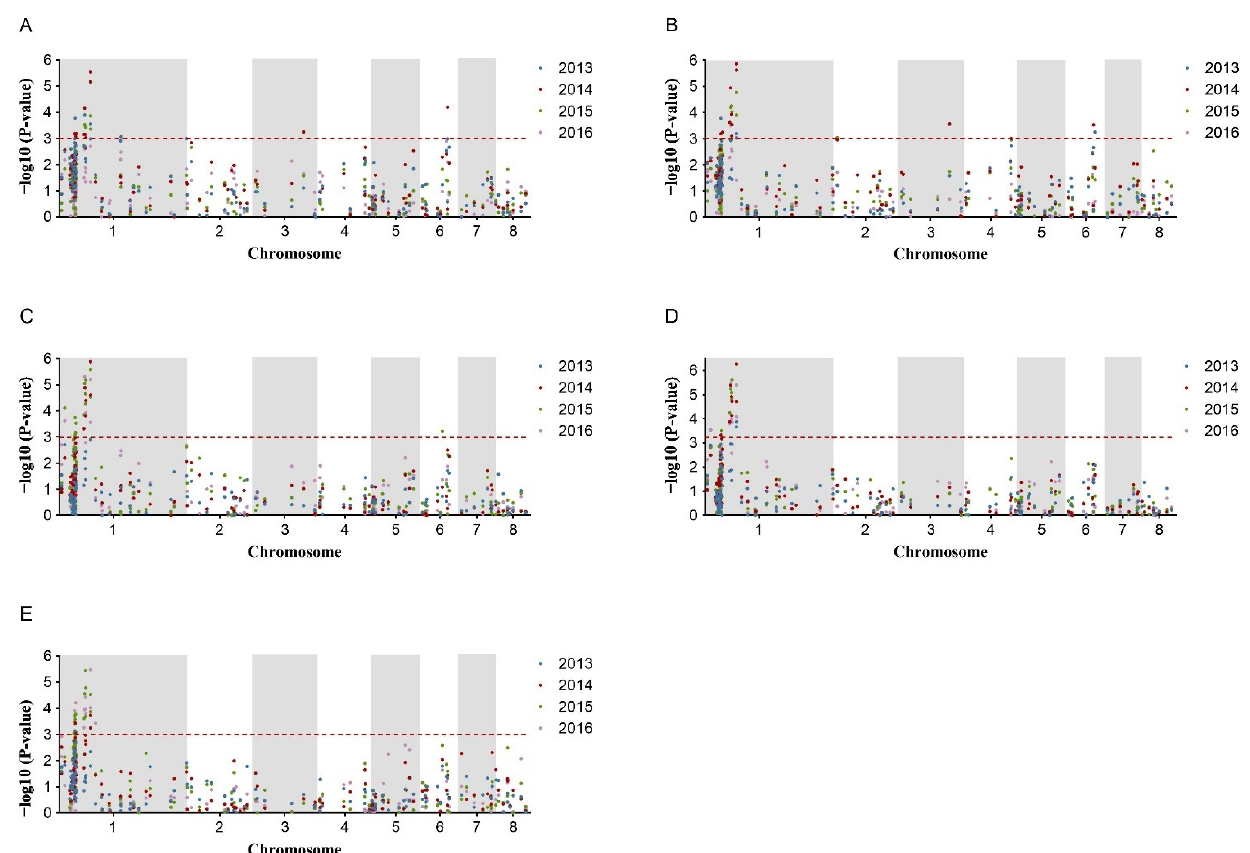
Figure 2. Manhattan plots of SSR and InDel markers associated with PA-related traits in the 8 chro- mosomes of lotus ( Nelumbo Adans.). ( A ) Petiole height, ( B ) peduncle height, ( C ) leaf length, ( D ) leaf width, and ( E ) flower diameter. The blue, red, green, and purple dots represent the results of associa- tion analysis in 2013, 2014, 2015, and 2016, respectively. The horizontal red dashed line indicates the threshold with significant differences at − log10 ( p value) = 3. Chromosomes and physical position of SSR and InDel markers were on the X -axis.